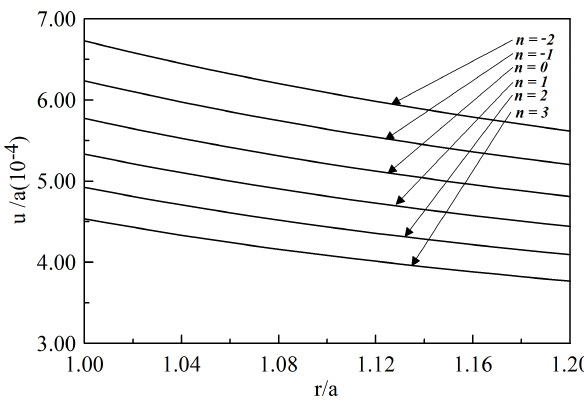
Figure 12: Radially distributed displacement